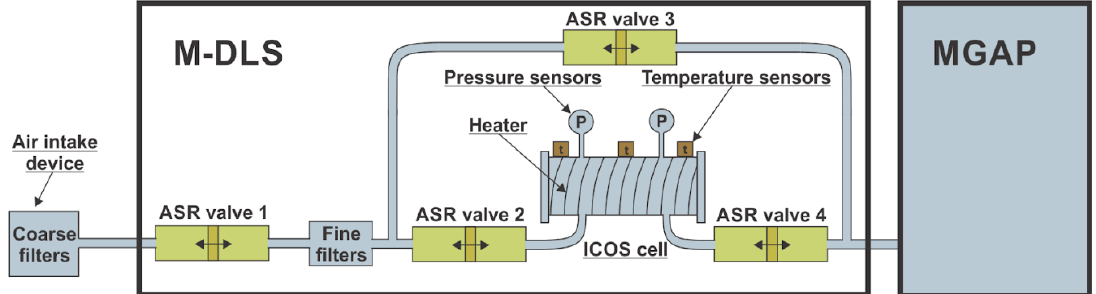
Figure 3. Principal Martian air sample preparation system diagram, joint for both the M-DLS and the MGAP (Martian gas analytical package) instruments. ASR valve is air sample regulation valve. The Martian air sample is purified by complex of coarse and fine filters. ASR valves 1, 2, 3, 4 and the MGAP pump control the Martian air sample update in the integrated cavity output spectroscopy (ICOS) cell. The ICOS cell contains multiple pressure and temperature sensors and is wrapped by nichrome wire (heater) for temperature maintenance.